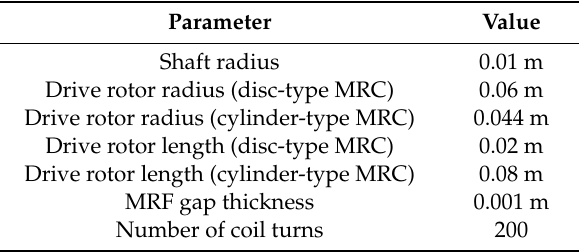
Figure 3. Half-section views of the clutches: ( a ) Disc-type MRC; ( b ) Cylinder-type MRC. Figure 3. Half ‐ section views of the clutches: ( a ) Disc ‐ type MRC; ( b ) Cylinder ‐ type MRC. Table 1. Design parameters of the Table 1. Design parameters of the clutches.